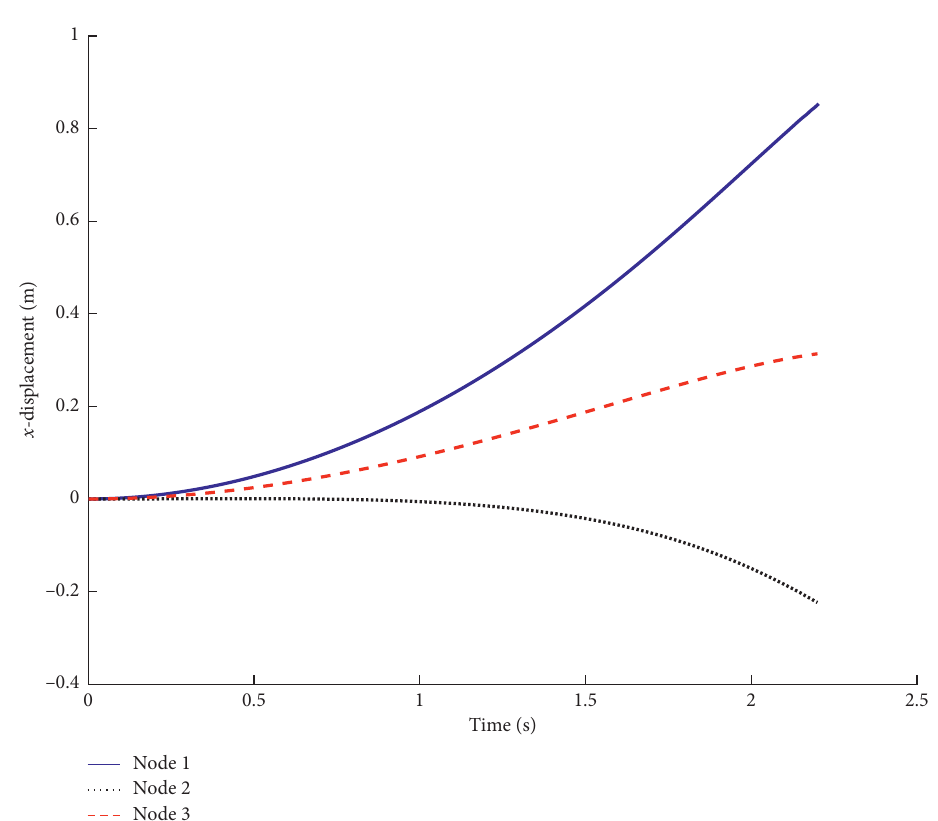
Figure 5: Curves of x -displacement over time for some nodes in the deployable